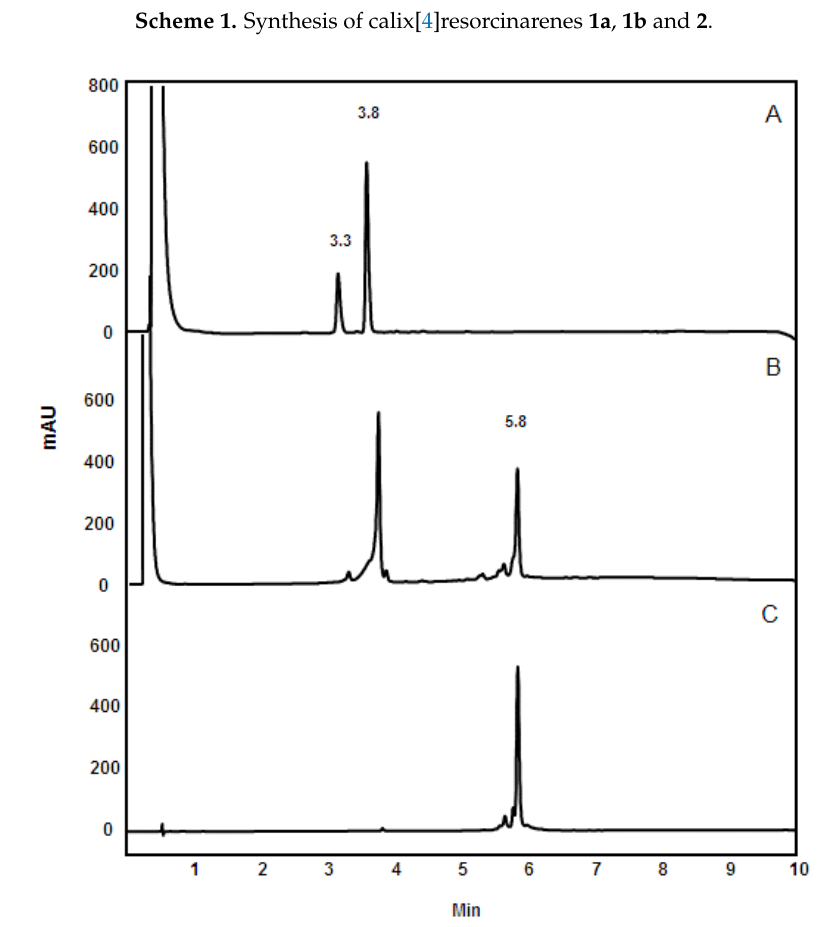
Figure 1. ( A ) Chromatogram of conformational isomers: crown conformation ( 1a ), t R = 3.3 min, chair conformation ( 1b ), t R = 3.8 min. ( B ) Chromatogram of reaction mixture. ( C ) Chromatogram of pure product 3 , t R = 5.8 min.